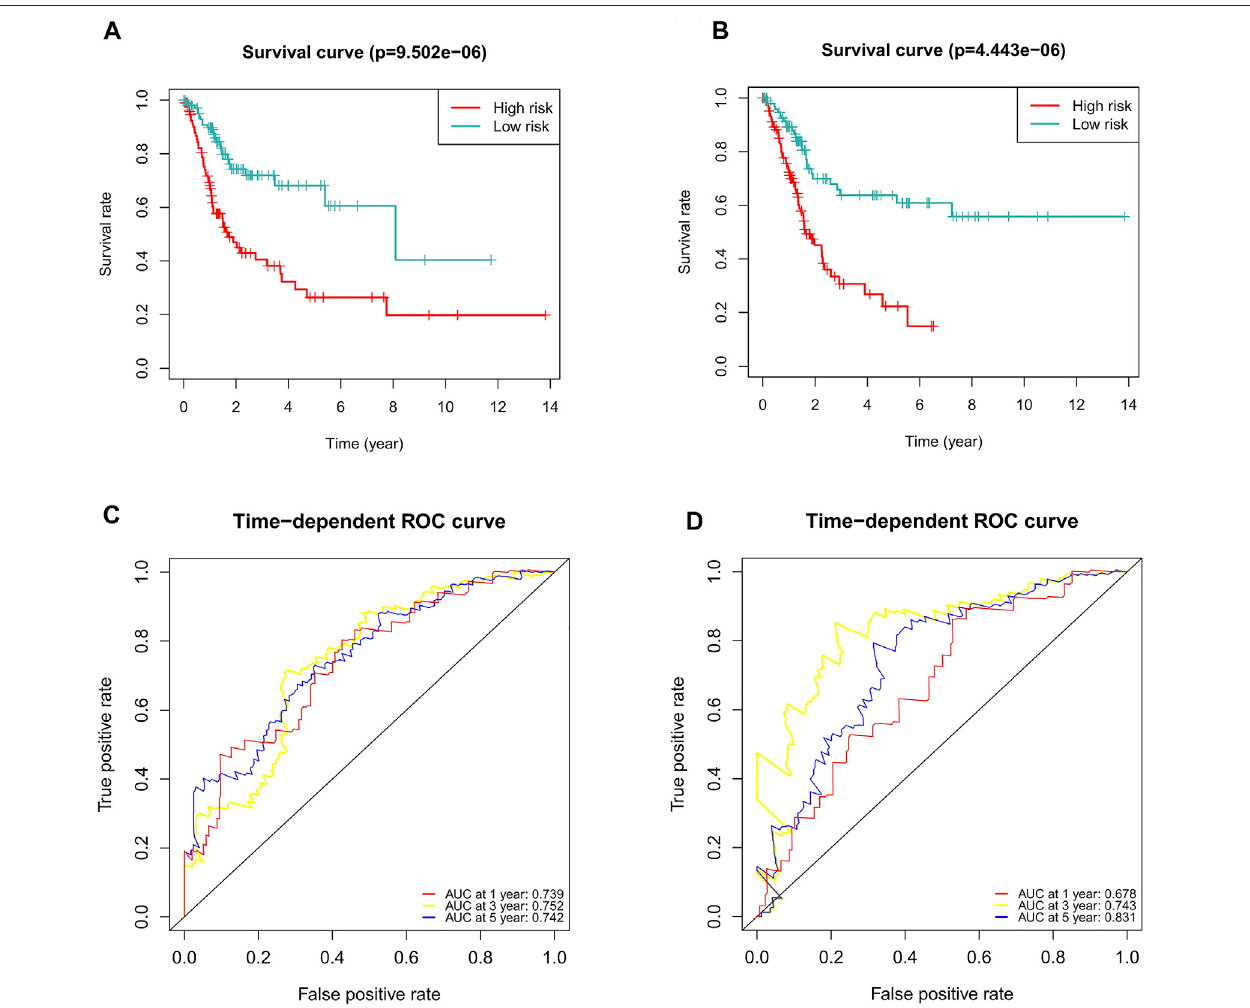
FIGURE 8 | Internal validation of the predictive signature for OS based on the entire TCGA dataset. (A) Kaplan-Meier survival curve in the fi rst internal cohort. (B) Kaplan-Meier survivalcurve inthesecondinternal cohort. (C) ROCcurve and AUCsat1-year,3-yearsand 5-yearssurvivalinthe fi rstinternalcohort. (D) ROCcurveand AUCs at 1-year, 3-years and 5-years survival in the second internal cohort. ROC, receiver operating characteristic; AUC, area under the curve; OS, overall survival; TCGA, The Cancer Genome Atlas.